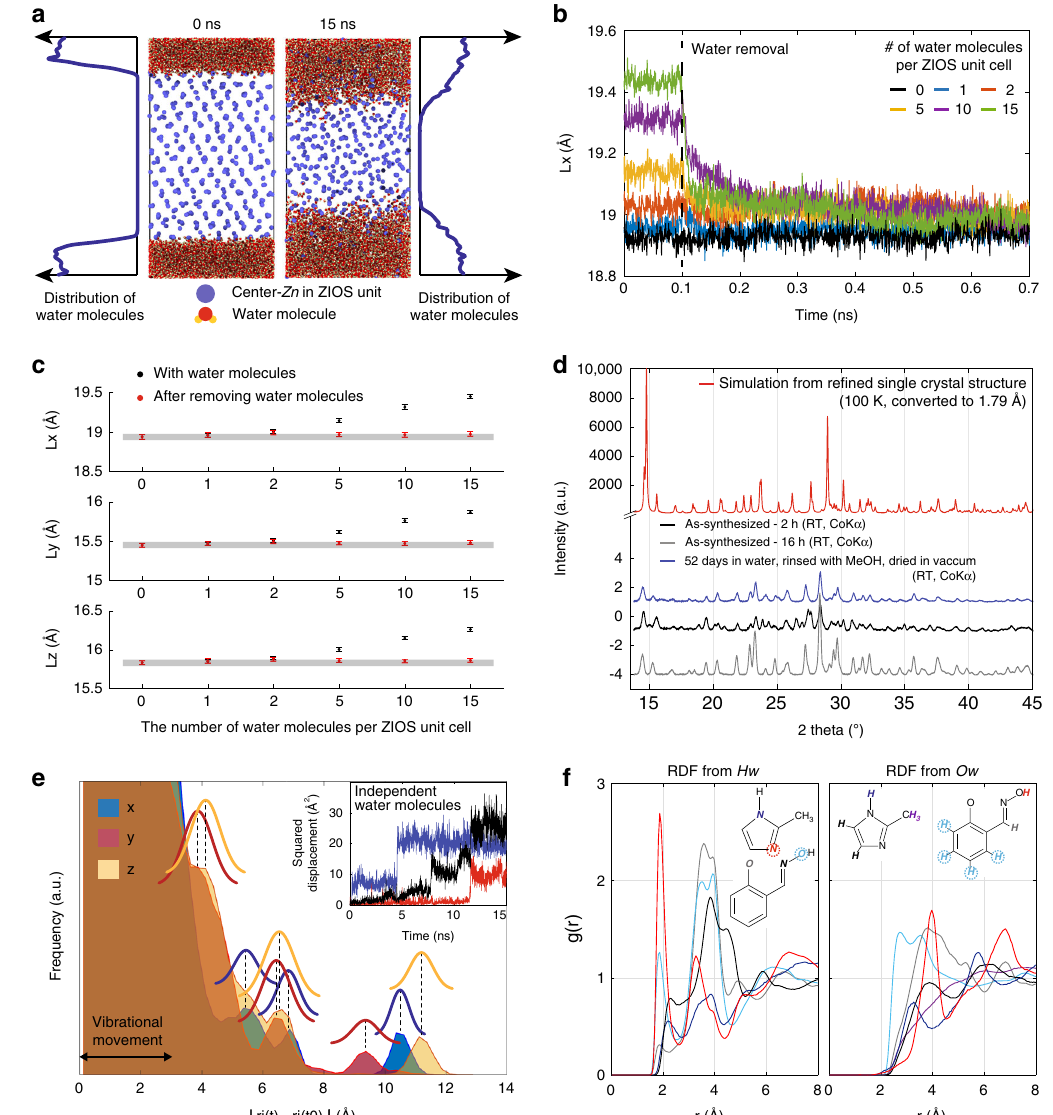
Fig. 6 Behaviors of ZIOS in aqueous environment via molecular dynamics simulation and PXRD. a Water penetrates into ZIOS within nanoseconds, based on a fl at two-dimensional channel simulation (4 × 4 × 8 ZIOS unit cells were originally placed with periodic 3-nm water channels). b , c For a periodic- boundary condition simulation box having 2 × 2 × 3 ZIOS unit cells and equilibrated state, simulations indicate clear lattice expansion when ZIOS is exposed to water and subsequent lattice contraction as water is removed. Simulations were performed separately with differing numbers of water molecules per ZIOS unit cell. d Comparison of a simulated ZIOS powder pattern from Rietveld re fi nement of synchrotron single-crystal X-ray diffraction data (red) with PXRD patterns of ZIOS obtained 2 h after synthesis (black), 16 h after synthesis (gray), and after being immersed in water for 52 days (blue). Notably, the powder pattern collected following extended water exposure is largely unchanged from the simulated pattern. e Water transport in ZIOS through hopping movement shown by histograms of spatial displacement of water molecules from their original positions (inset: squared displacement of independent water molecules with time). A representative case of ten water molecules per ZIOS unit cell is presented. f Radial distribution function showing the interaction of water molecules with the critical atoms in ZIOS unit via hydrogen bonds. The case of fi ve water molecules per ZIOS unit cell was used in this analysis. The most active hydrogen-bond acceptor sites are